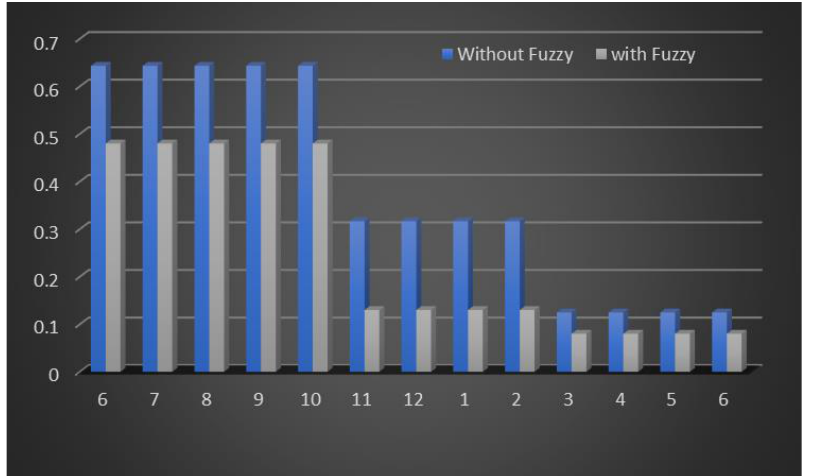
Figure 8 – Difference of SSL energy consumption with and without applying fuzzy logic Рис. 8 – Разница в энергопотреблении умной системы уличного освещения с применением нечеткой логики и без нее Слика 8 – Разлика у потрошњи енергије паметног система уличног осветљења са применом фази логике и без њене